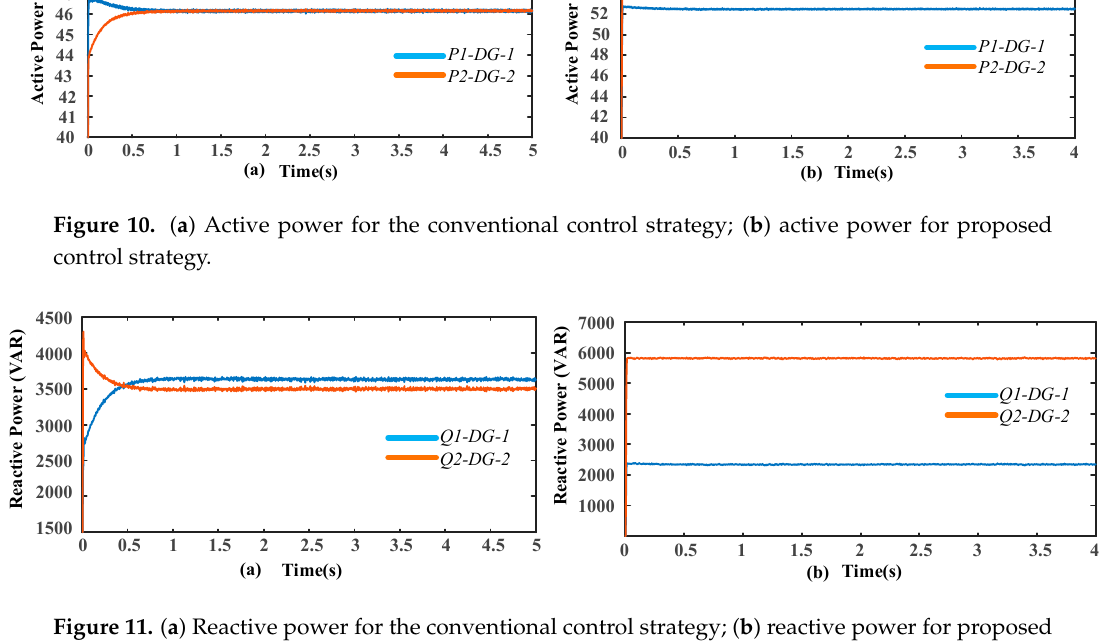
Figure 13. ( a ) Active power for the conventional control strategy; ( b ) active power for proposed control strategy. 0 0.1 0.2 0.3 0.4 0.5 0.6 0.7 0.8 0.9 11000 1050 11001150120012501300 13501400